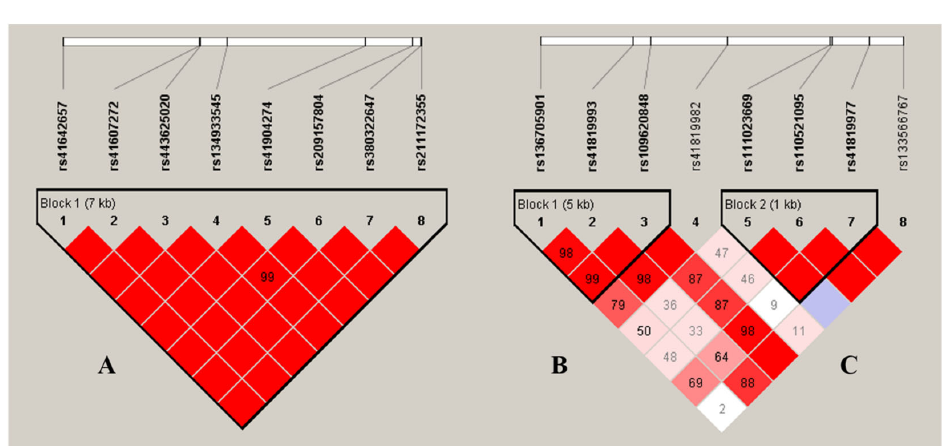
Figure 1. Linkage disequilibrium estimated among the SNPs in ACADVL (A; D’ = 0.99~1.00) and IRF6 (B: D’ = 0.98~1.00; C: D’ = 1.00). The blocks indicate haplotype blocks and the text above the horizontal numbers is the SNP names. The values in the red boxes are pairwise SNP correlations (D’), while bright red boxes without numbers indicate complete LD (D’ =